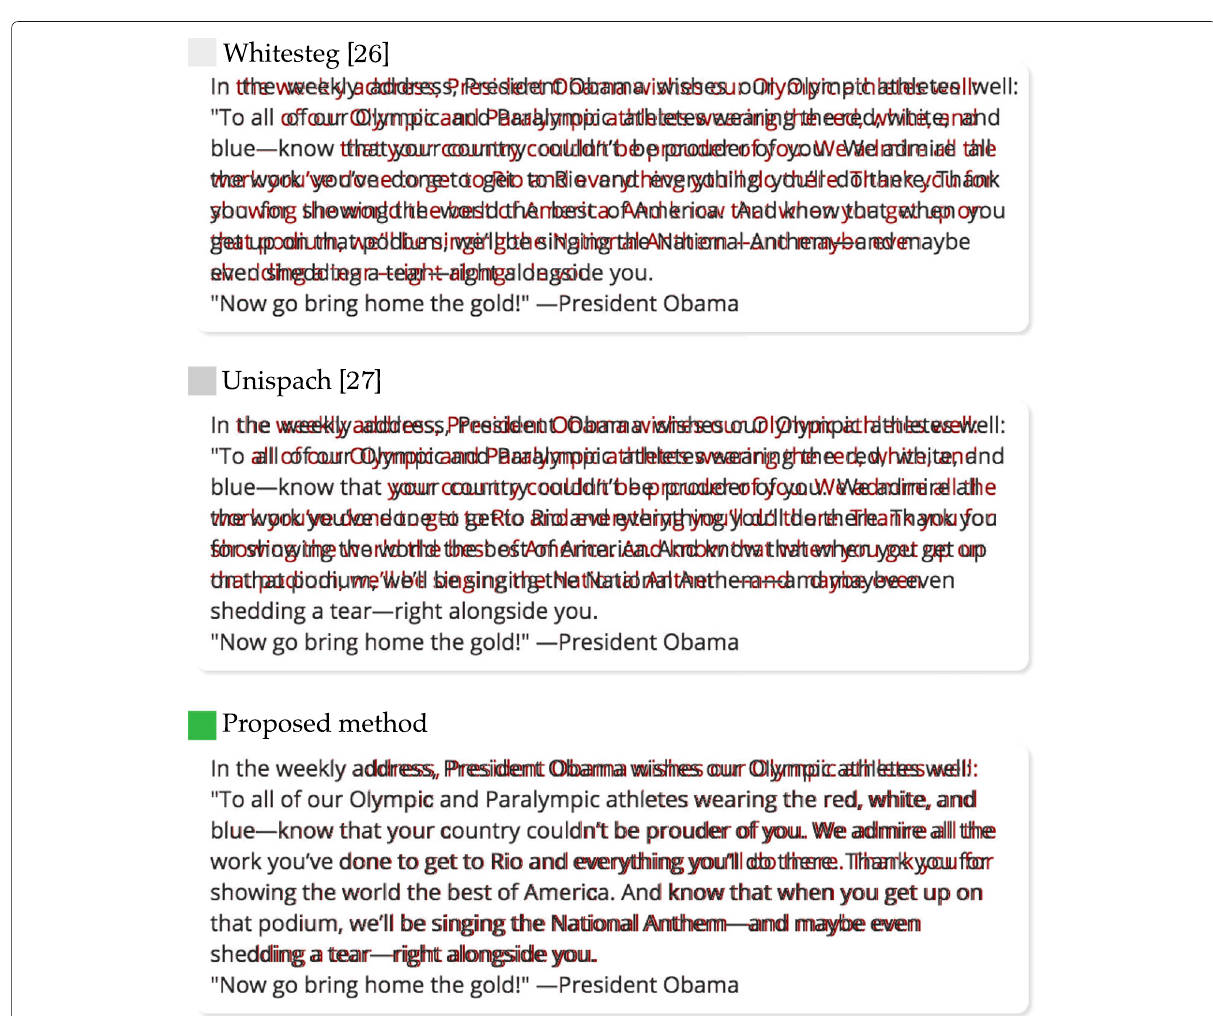
Fig. 10 Indistinguishability test. Overlapping original and watermarked text for content-preserving methods shows less noticeable changes with proposed